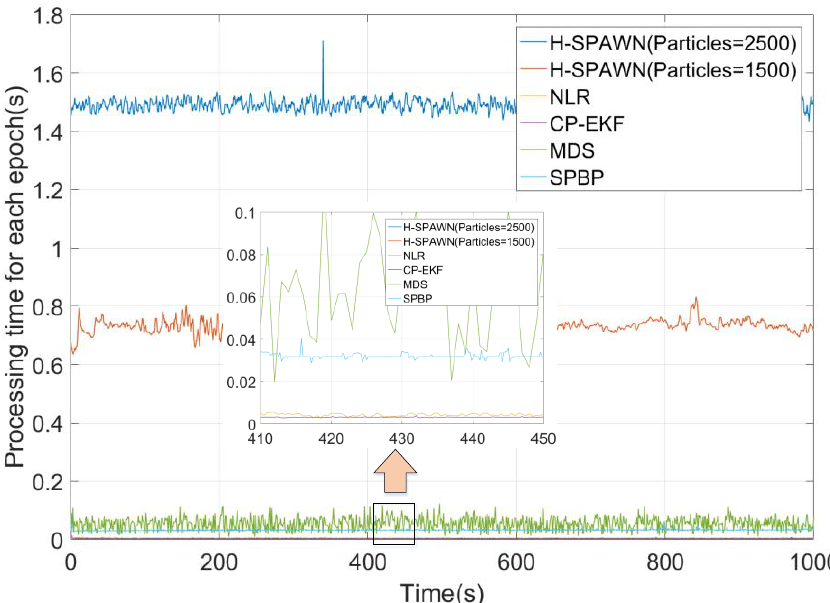
Figure 8. Example of processing time at each computation epoch: H-SPAWN (particle number = 2500), H-SPAWN (particle number = 1500), NLR, CP-EKF, MDS, SPBP.